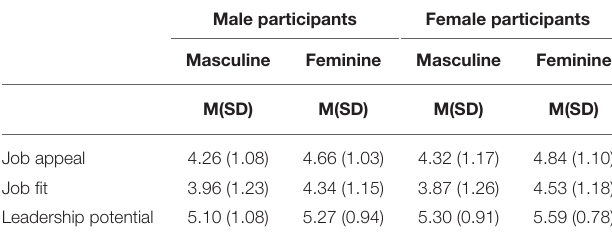
TABLE 5 | Study 2: means and standard deviations for job appeal, job fit, and self-rated leadership potential.